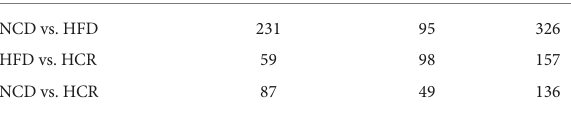
gene expression signature of NAFLD, among which the potential genes could play pivotal roles for protecting from NAFLD and its associated metabolic disorders.